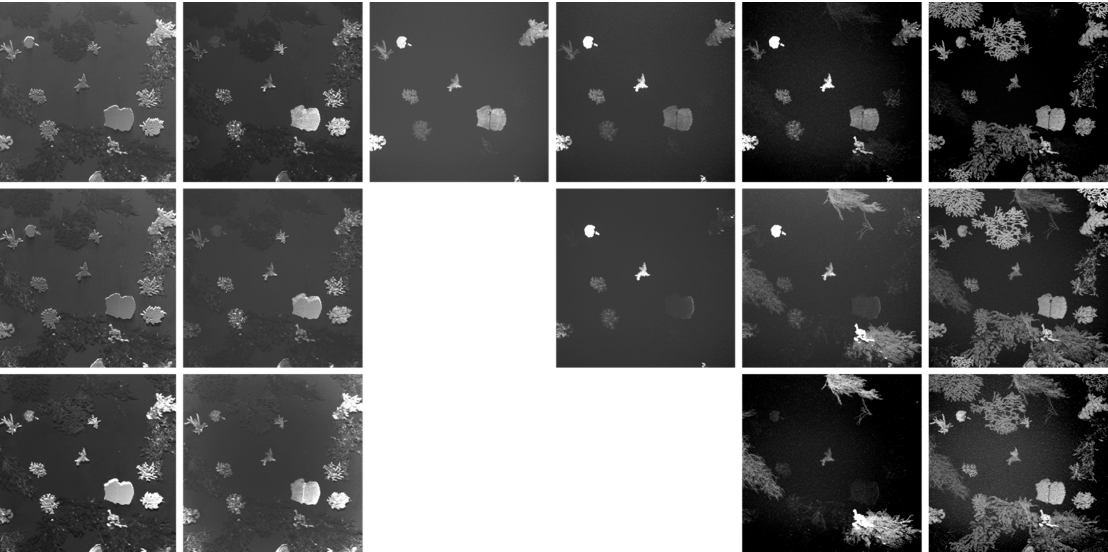
Figure 7. Images recorded through spectral response of macroalgae and coral species, from excitation at 450 nm (top row), from left with reflectance at 450 nm without filter, reflectance with bandpass filter, and emission at 490, 520, 580, and 685 nm; excitation at 490 nm (middle row), and from left with reflectance at 490 nm without filter, reflectance with bandpass filter, and emission at 520, 580, and 685 nm, and excitation at 520 nm (bottom row), and from left with reflectance at 520 nm without filter, reflectance with bandpass filter, and emission at 580 and 685 nm.